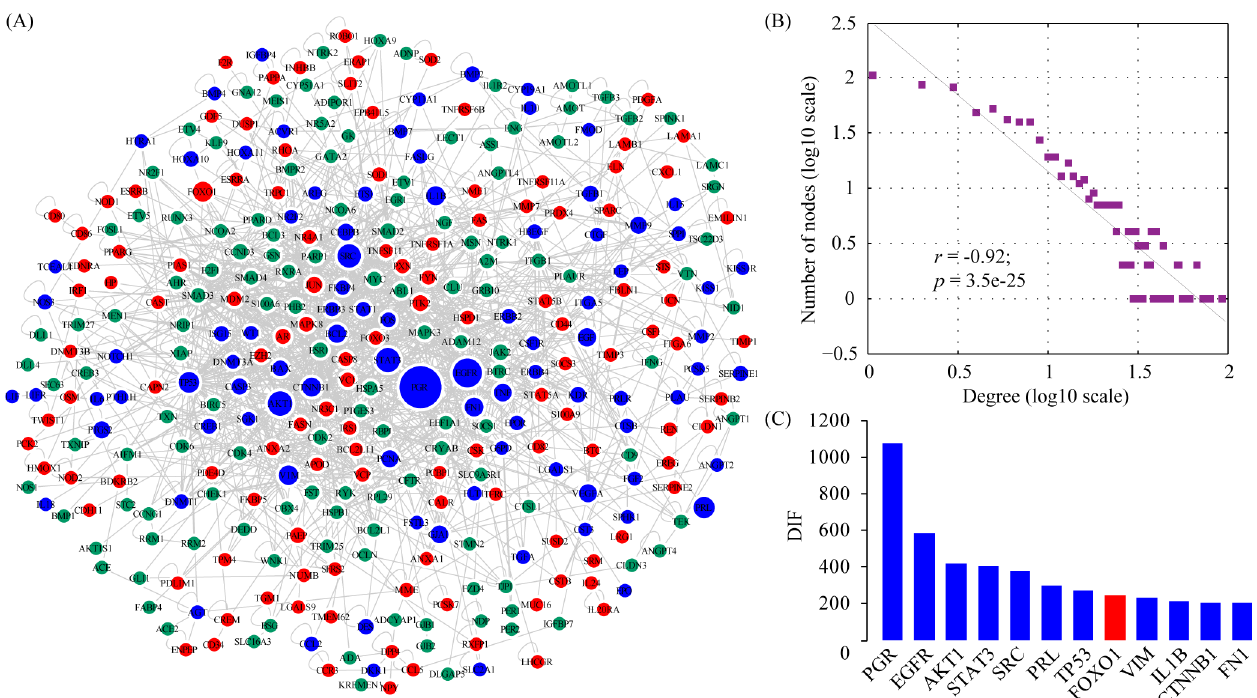
Fig 4. Gene prioritization by protein-protein interaction (PPI) network analysis. (A) The structure of the PPI network of decidualization-related genes. Nodes are color-coded (red, human-specific; green, mouse-specific; blue, shared by both) and the diameter of each node is proportional to its decidualization impact factor (DIF) value. (B) Degree distribution of the PPI network. The degree distribution follows a power law distribution. (C) Bar plot showing the DIF values for all selected genes with DIF values exceeding the mean plus two standard deviations.